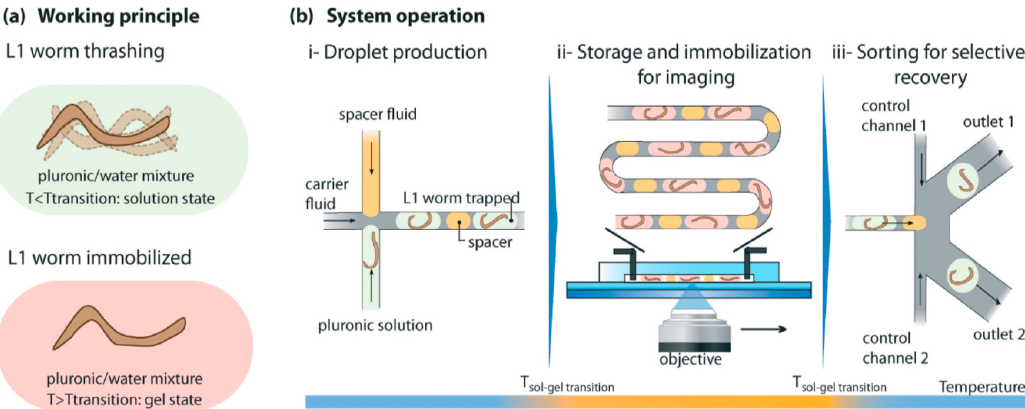
Figure 3. A schematic representation of the method of immobilization, imaging and sorting of worms developed by Aubry et al. [38]. ( a ) The working principle whereby the worm can thrash in a Pluronic liquid medium and is immobilized in the gel medium; ( b ) the operating principle whereby Aubry et al. separated a single worm at (i), store, immobilize and image the worm (ii) and sort the worm (iii). This illustration also indicates the corresponding change in temperature in different modules. Reprinted with permission from the Royal Society of Chemistry.